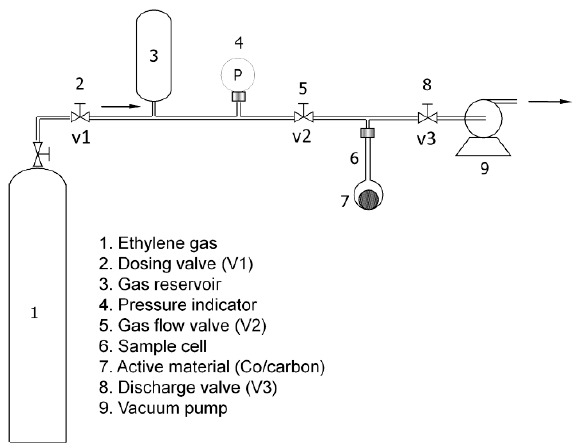
Figure 6. The schematic diagram of the adsorption rig employed for the ethylene adsorption test. The amount of ethylene adsorbed ( Δ n ) was calculated using Equation (4).